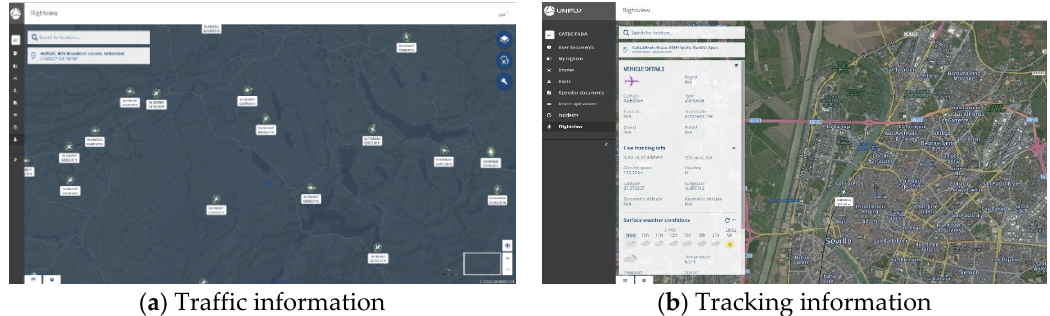
Figure 12. Tra ffi c information received by U-space users. Figure 12. Traffic information received by U-space users. Figure 12. Traffic information received by U-space users.